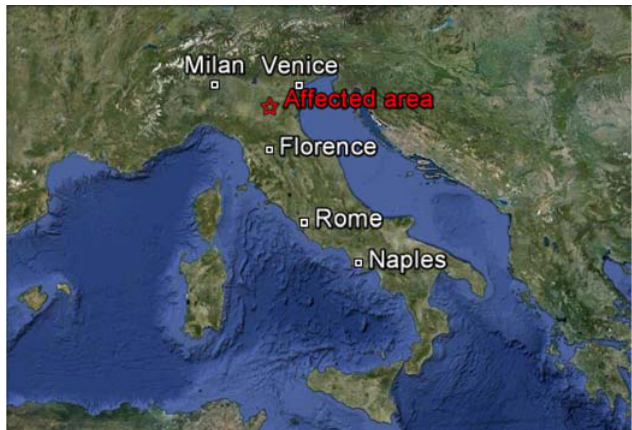
Figure 1. Location of the affected